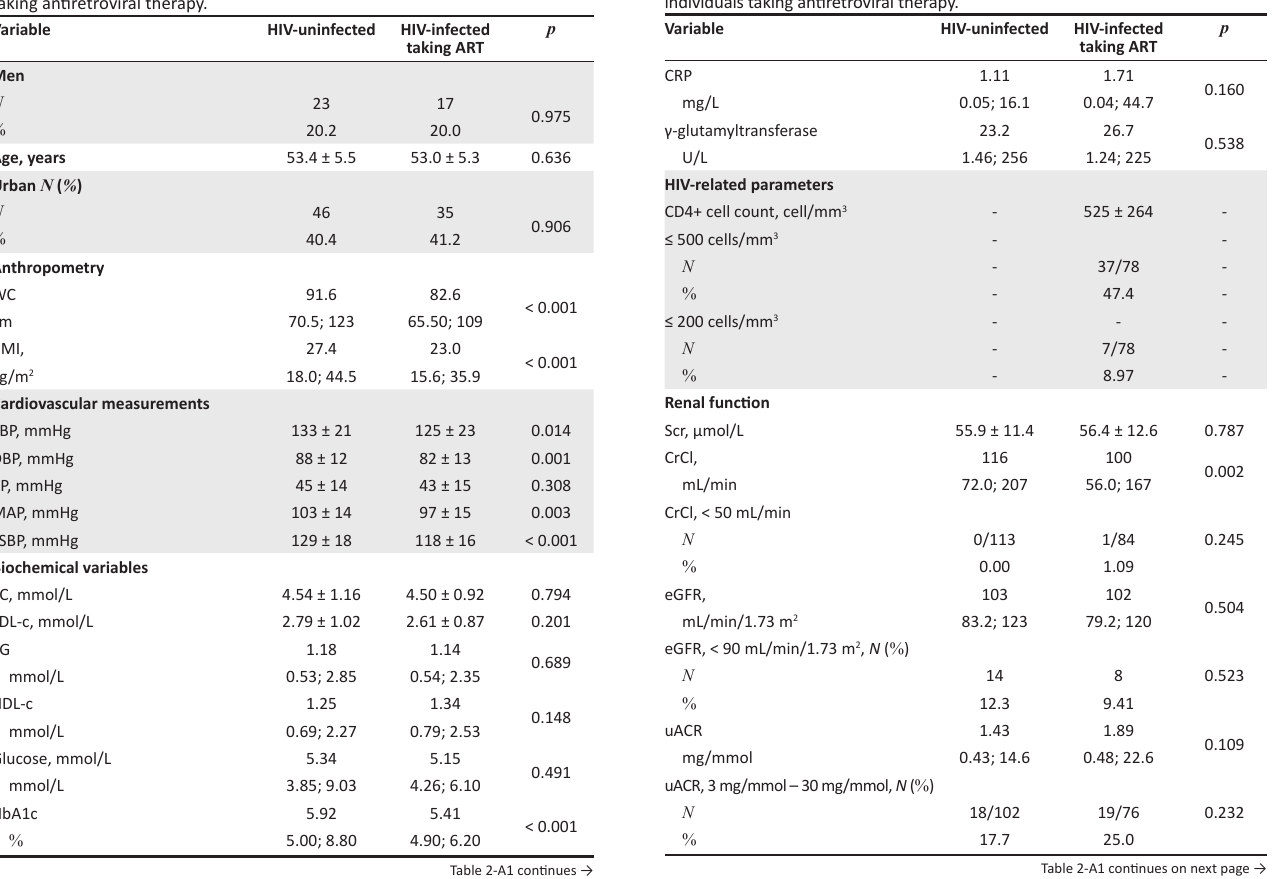
Table 2-A1 continues →